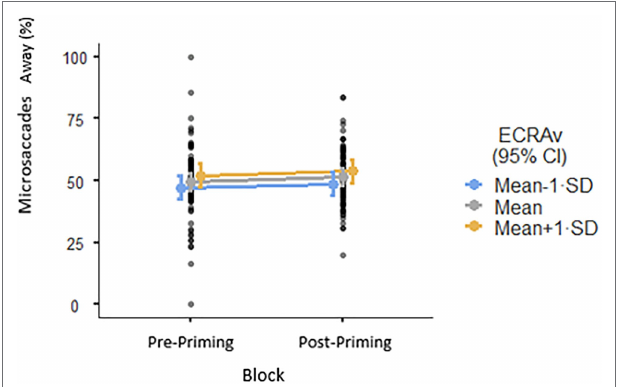
FIGURE 2 | Attention to facial stimuli as a function of avoidance (ECR-R), as captured by microsaccades away from the stimuli.